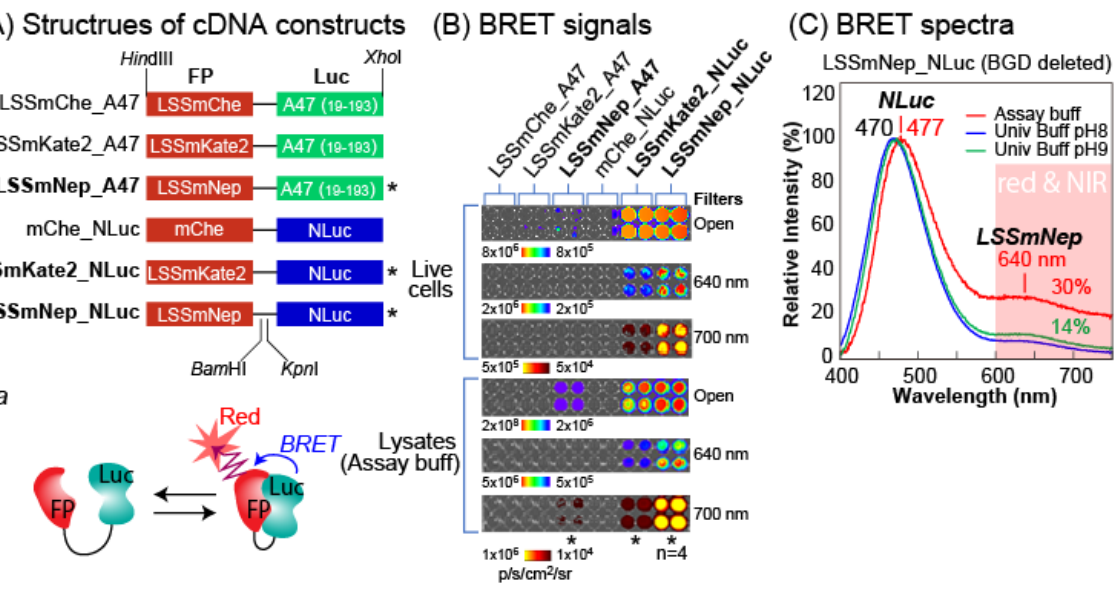
Figure 3. ( A ) Schematic diagram of cDNA constructs encoding various combinations of fluorescent protein (FP) and luciferase, designed for BRET imaging. Inset ‘ a ’ shows the typical working mecha- nism of the BRET probes after expression. ( B ) The BL images of various BRET probes in the presence of the specific substrate, CTZ for ALuc47-bearing probes (left side), or DBlueC for NLuc-bearing probes (right side). The images were captured with open, 640-nm, or 700 nm band-pass filter ( n = 4). The asterisks (*) highlight brighter probes. ( C ) The BL spectra of LSSmNep_NLuc in various buffer conditions. The red shadow highlights the red and NIR region of the spectra.